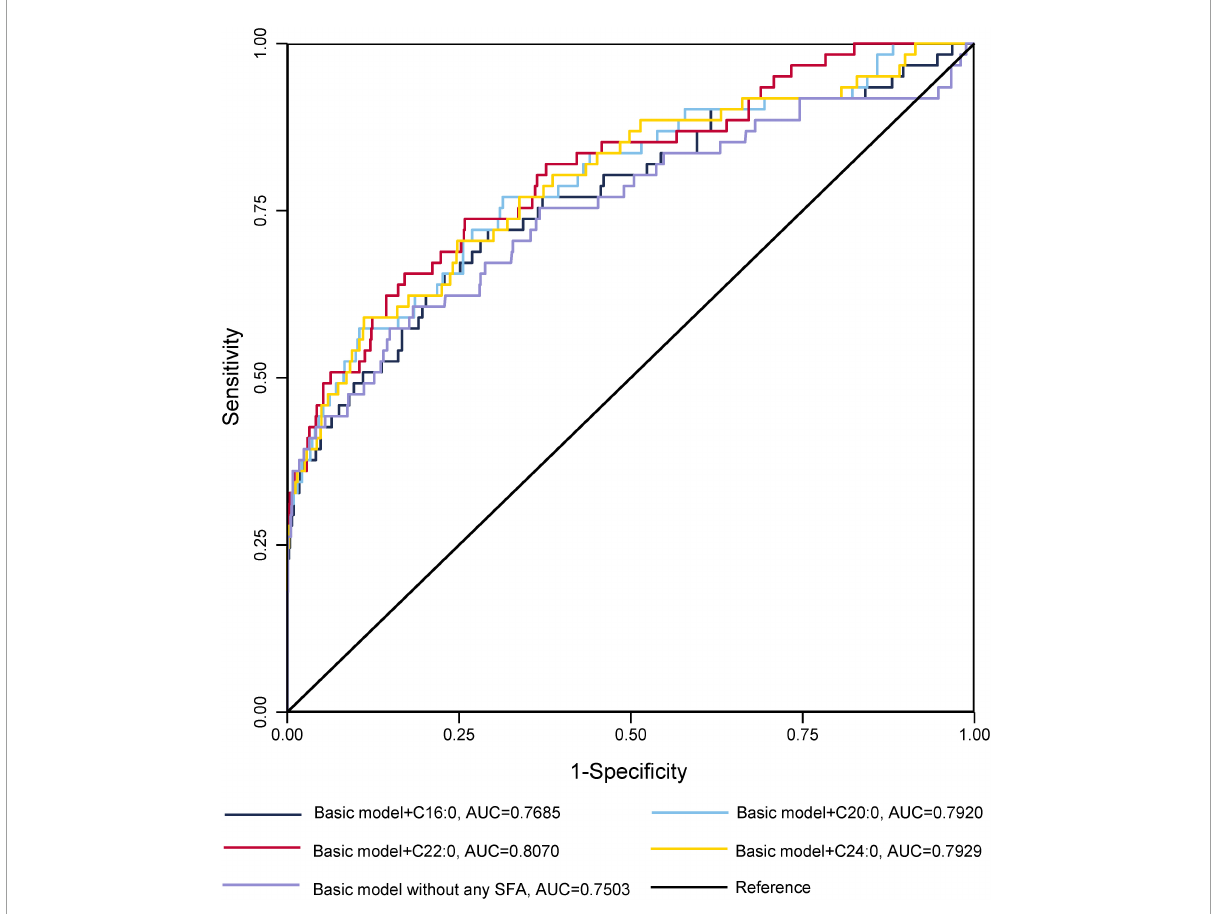
FIGURE2 Receiver operating characteristic curves for GDM without or with the addition of a single SFA for GDM diagnostic models in cross-sectional study participants.